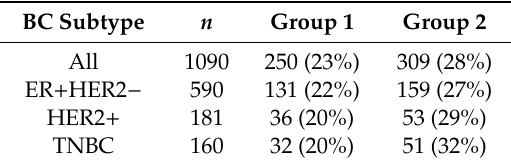
Table 3. PD-1-Associated Gene Expression Signature in HER2 + Breast Cancer (PAGES-HBC) Group 1 and Group 2 patients in the The Cancer Gene Atlas (TCGA) breast cancer data set.